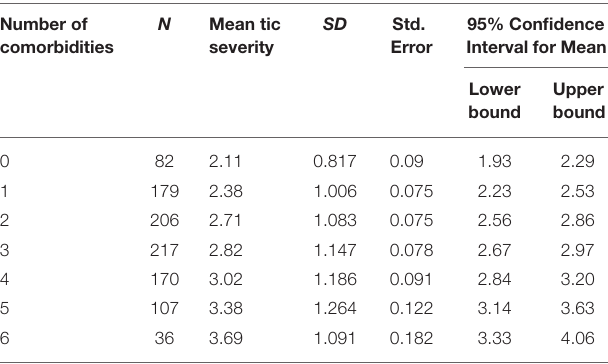
TABLE 3 | Association between number of comorbidities ( = comorbidity score) and mean tic severity*. Number of